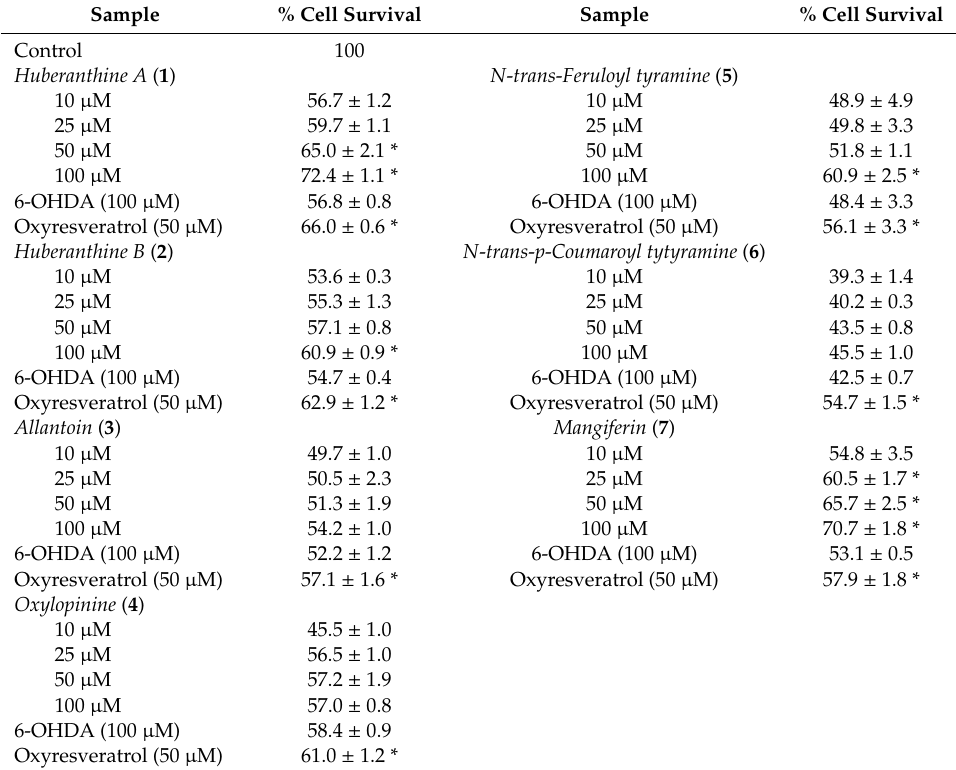
Table 2. Neuroprotective activity of compounds 1 – 7 .